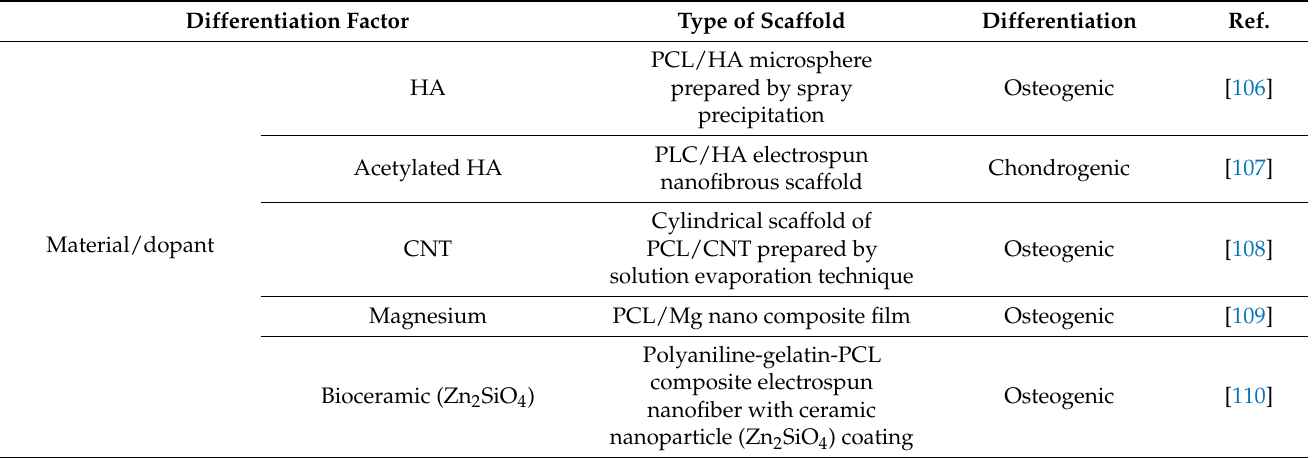
Table 1. PCL and cell